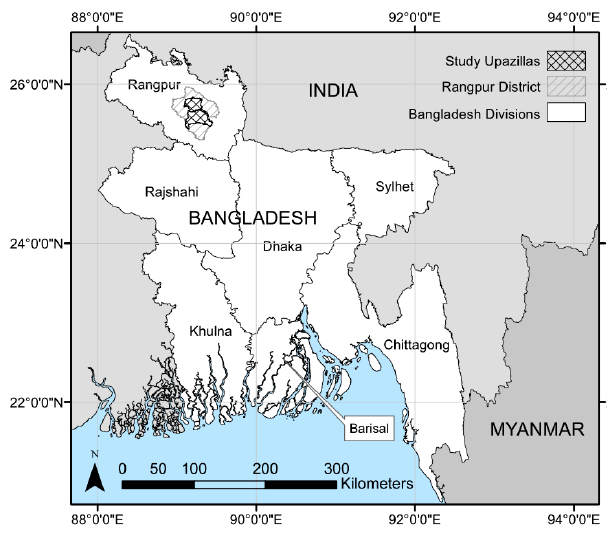
Fig. 1 . Map showing the location of the field site. Upazilas =